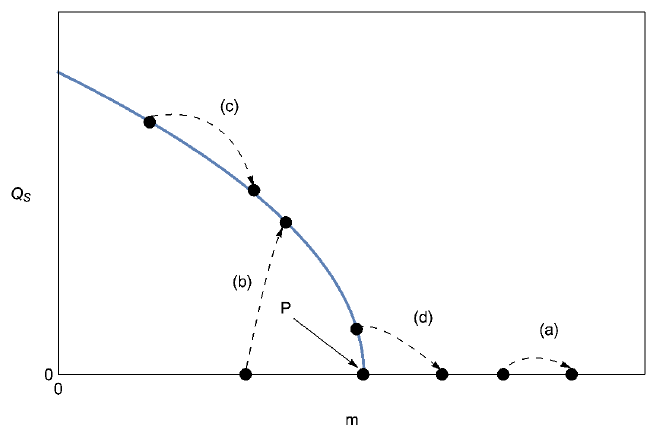
Figure 1 . Schematic diagram for different far-from-equilibrium evolutions. The vertical axis indicates the scalar charge, while the horizontal one denotes the Arnowitt-Deser-Misner (ADM) mass of the static HBH solutions. The blue curve is the collection of static HBH solutions, specified below in section 3. The point P on the horizontal axis indicates the value of the threshold mass. An initial configuration with a mass above this threshold value will eventually evolve into a bald black hole, while a system with a mass below it will settle down to a hairy black hole. As indicated in the figure, the dashed curves with arrows, labeled by (a) to (d), correspond to the four different scenarios explored in this study. The arrows indicate the directions of temporal